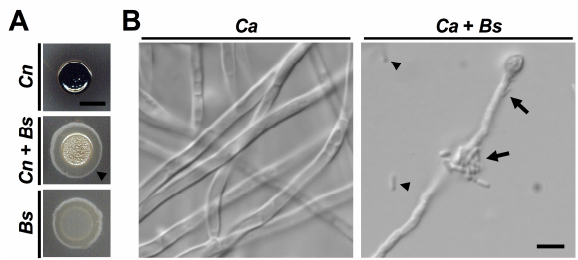
FIGURE 1: B. safensis inhibits virulence factor production by pathogenic fungi. (A) The C. neoformans wild type strain H99, B. safensis , or a mixture of both were spotted onto L-DOPA agar and incubated at 37°C for three days before being